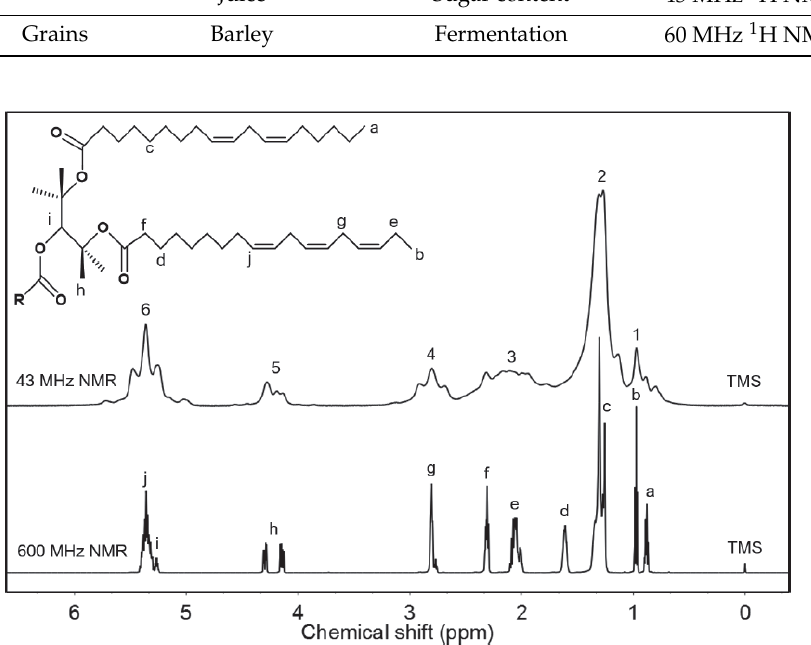
Figure 1. 1 H nuclear magnetic resonance (NMR) spectra of authentic perilla oil acquired on a 43 MHz benchtop NMR spectrometer and a 600 MHz high-resolution NMR spectrometer. Adapted with permission from [15], J-STAGE, 2018.